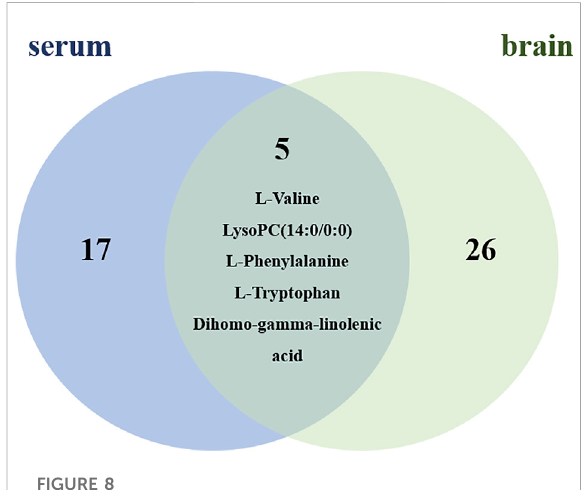
FIGURE 8 Metabolite differences between serum and brain samples.